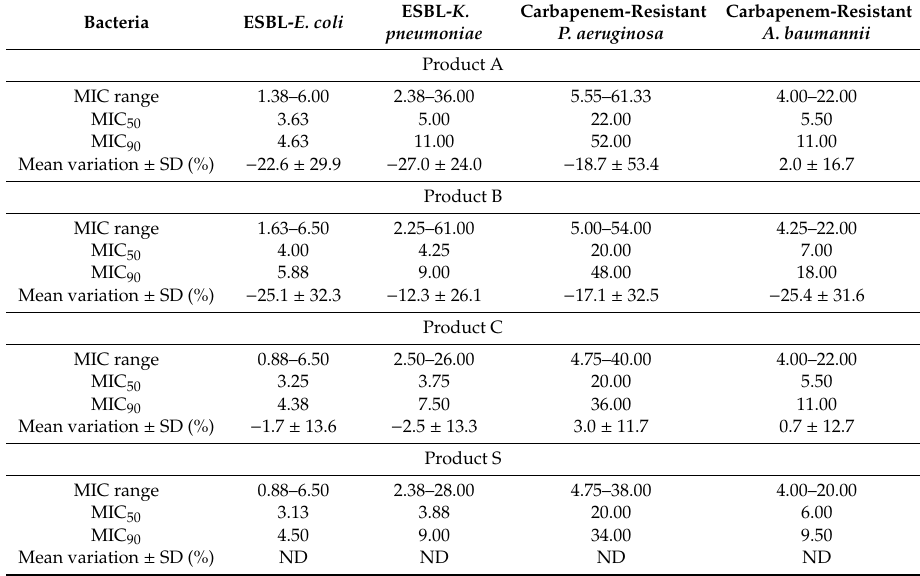
Table 2. Minimum inhibitory concentration (MIC) results of all cefoperazone / sulbactam formulas against extended-spectrum β -lactamase (ESBL)- E. coli , ESBL- K. pneumoniae , carbapenem-resistant